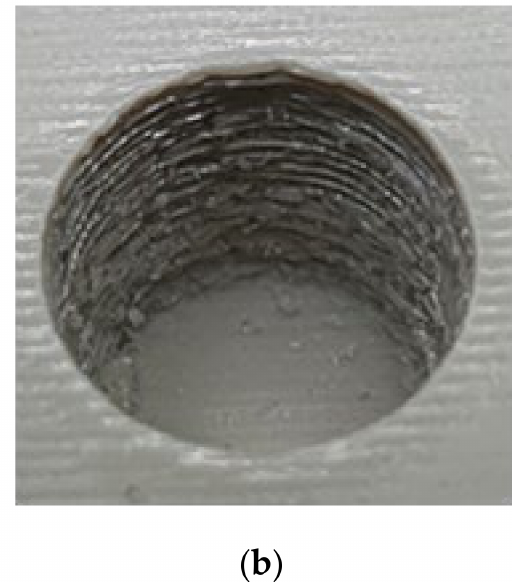
Figure 24. ( a ) Core face of the moulded part showing signs of progressive deterioration; ( b ) cavity side of the moulded showing no signs of progressive deterioration (moulded using insert B). The red circles highlight the areas of interest and show deterioration of the core pin (broken bits of core pin) after each shot.